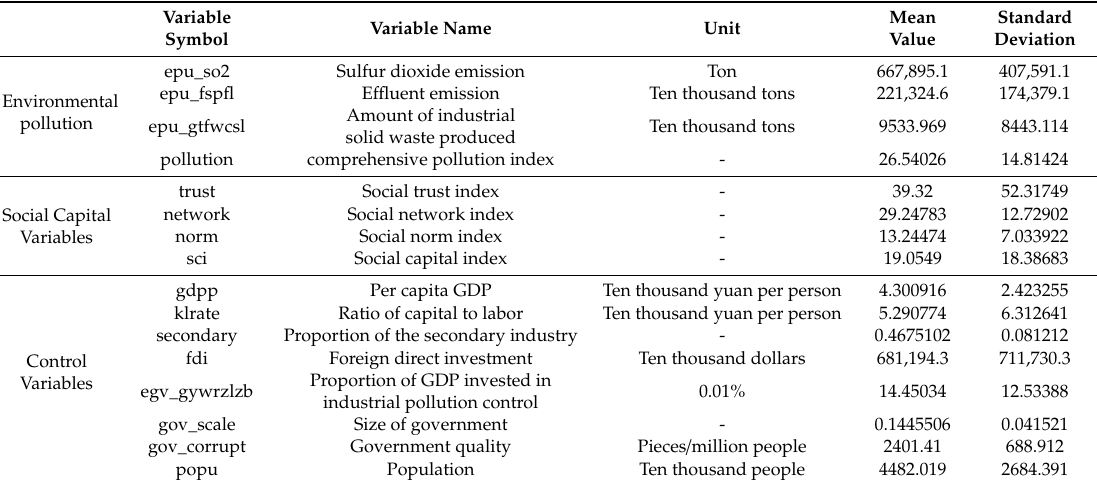
Table 1. Variable